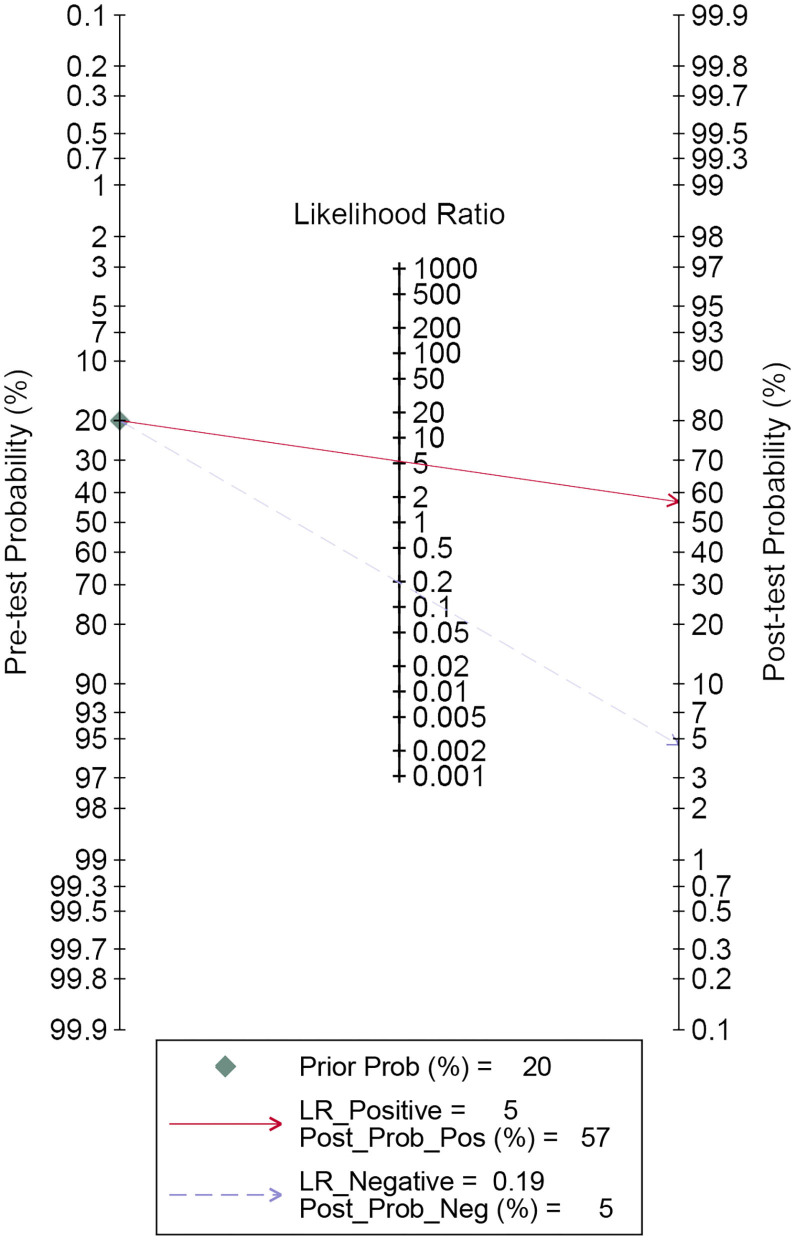
Fagan's plot for estimating post-test possibility. The red solid line denotes post-test probability when the index test is positive. While the blue dashed line indicates post-test probability with the negative index test result.